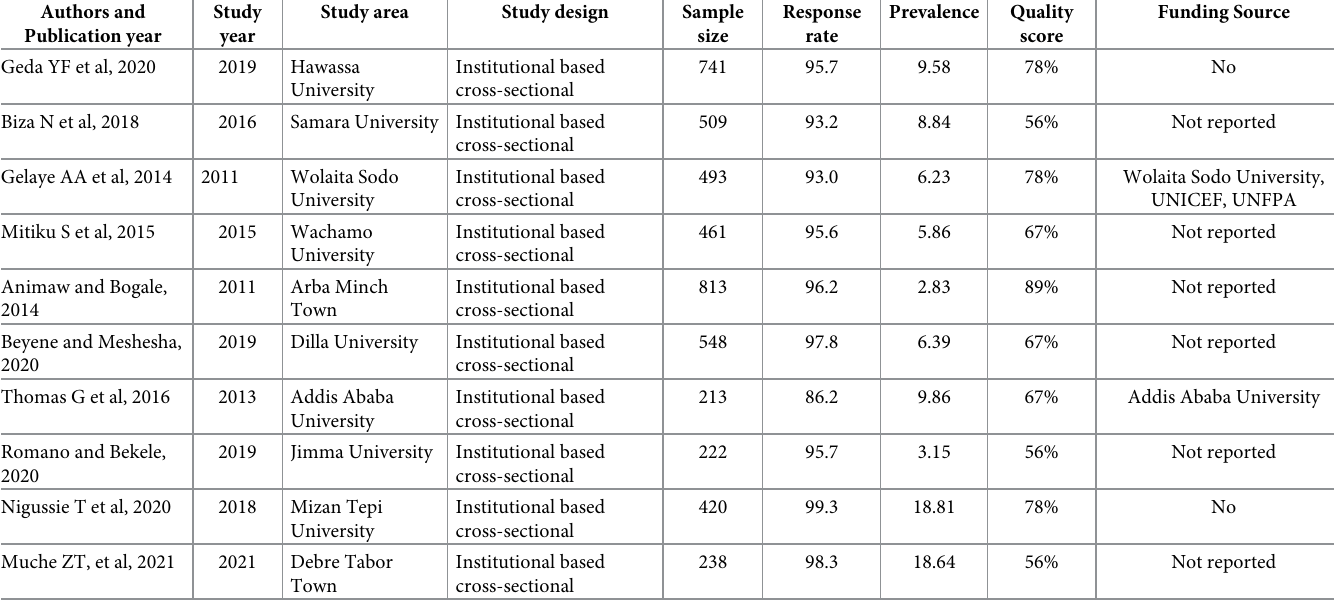
Table 1. Summary characteristics of studies included in the systematic review and